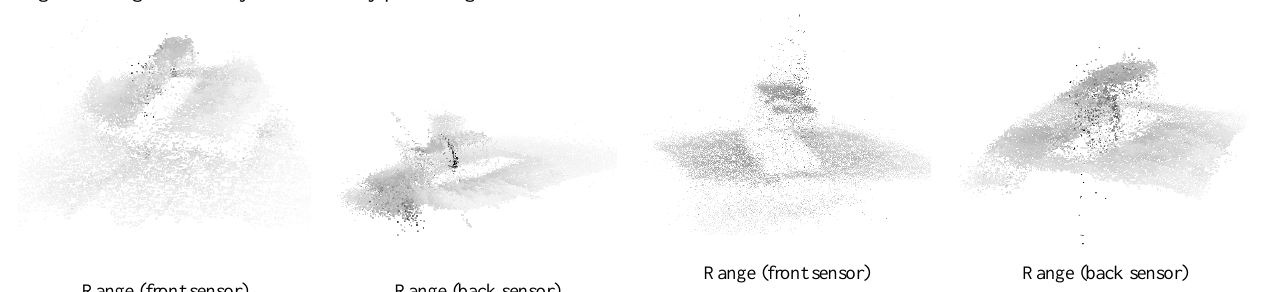
Figure 10. Single shot point cloud results of the parallel acquisition